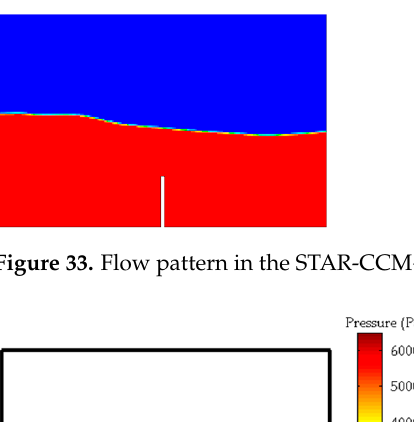
Figure 32. Pressure distribution in the STAR-CCM+ simulation with the baffle.